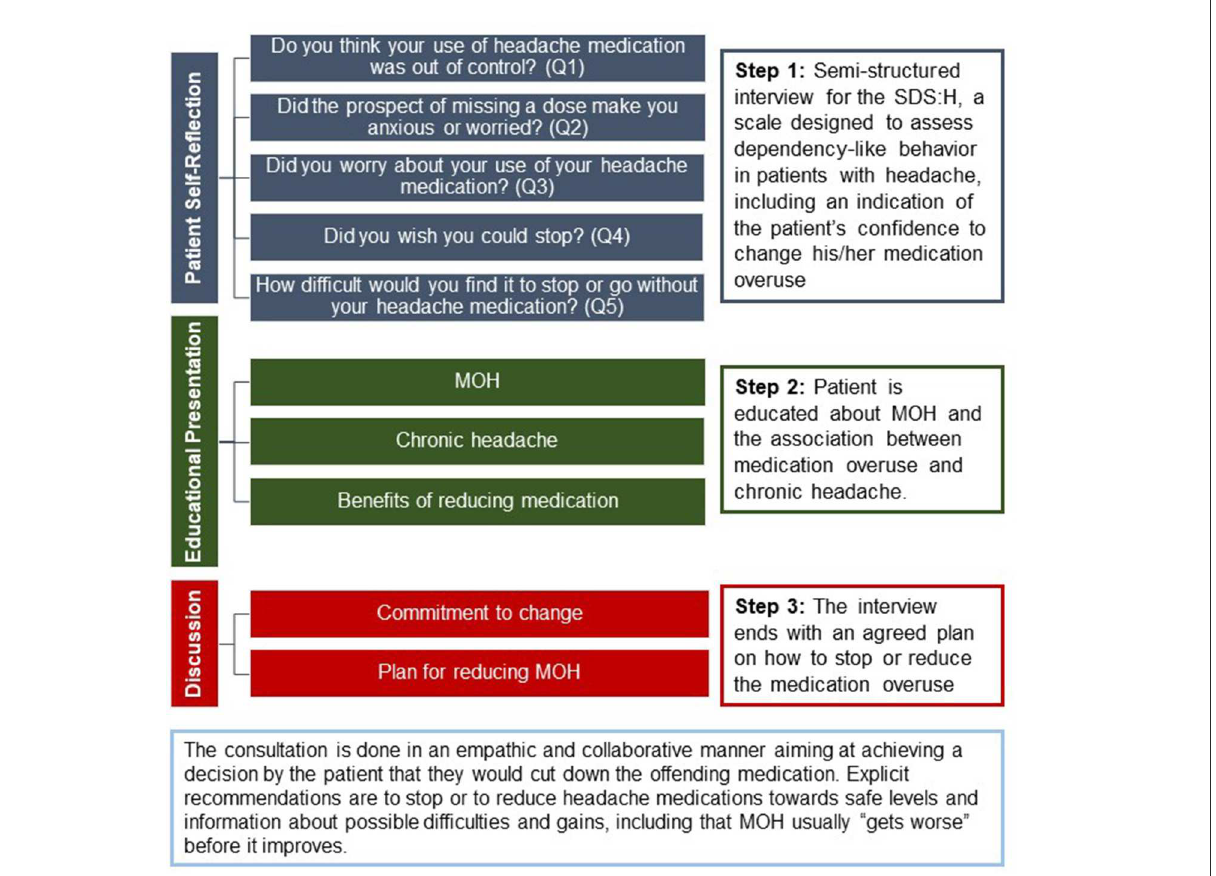
FIGURE2 BEI: Assessing dependency-like behavior in patients with headache. The structure of Brief Educational Intervention (BEI) for treatment of MOH. MOH, medication-overuse headache; Q1–Q5, Questions 1–5; SDS:H, Severity-Dependence Scale for Headache.